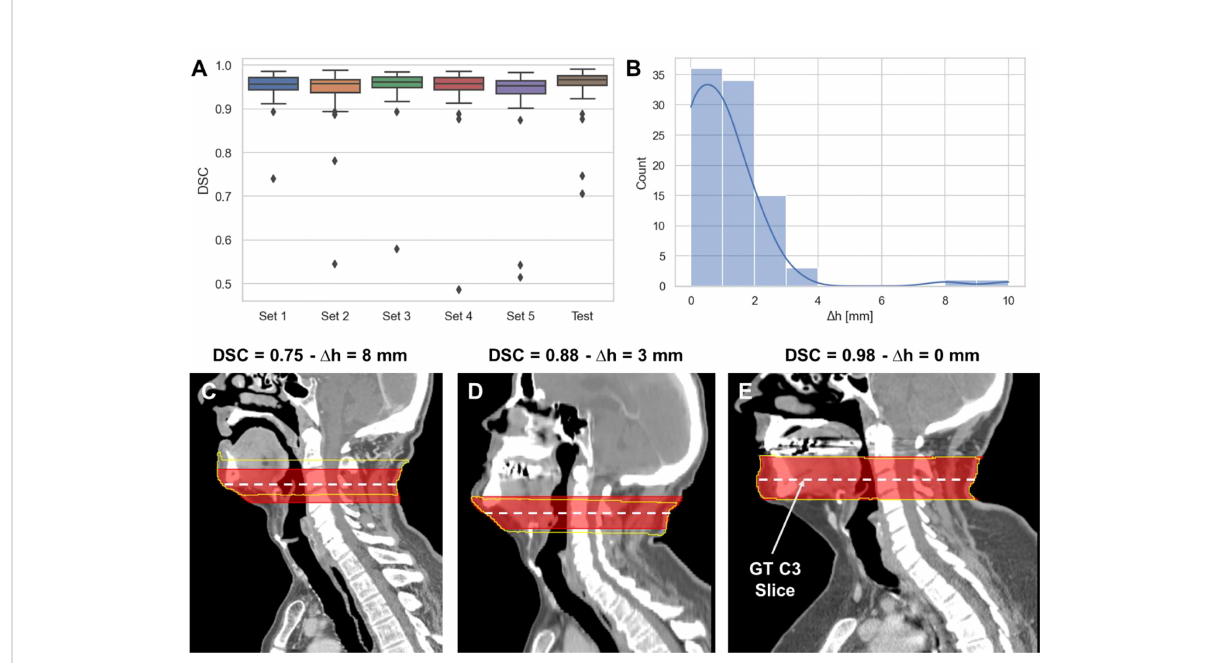
FIGURE 2 3D ResUNet model performance for segmentation of C3 vertebra section. (A) Boxplots of the Dice similarity coef fi cient (DSC) distributions for the 5-fold cross-validation data sets (Set 1 to Set 5 – 60 patients each) and the test data (90 patients). (B) Histogram of the absolute difference (in mm) of the C3 slice location at the middle slice of the auto-segmented C3 section and the location of the ground-truth manually segmented CT slice. Illustrative examples overlaying the C3 ground-truth segmentations (red) (33 mm centered at the ground-truth manually segmented CT slice) and predicted segmentations (yellow) on the CT images with different DSC values (low – 0.75 (C) , medium – 0.88 (D) , and high – 0.98 (E) performance compared to the mean DSC value of 0.95). The middle slice at the center of mass of the segmented C3 region was auto-selected for further skeletal muscle auto-segmentation by the 2D ResUNet